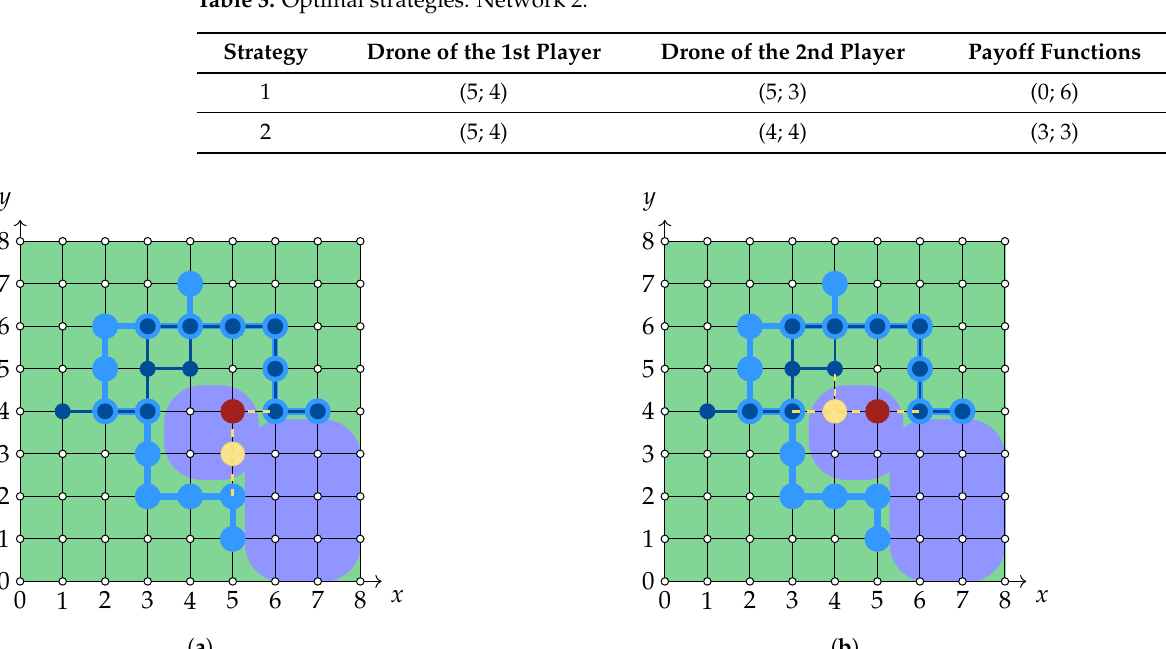
Figure 6. Two optimal strategies yielding the same value of the total payoff function. ( a ) strategy ( 5;4 ) / ( 5;3 ) ; ( b ) strategy ( 5;4 ) / ( 4;4 )